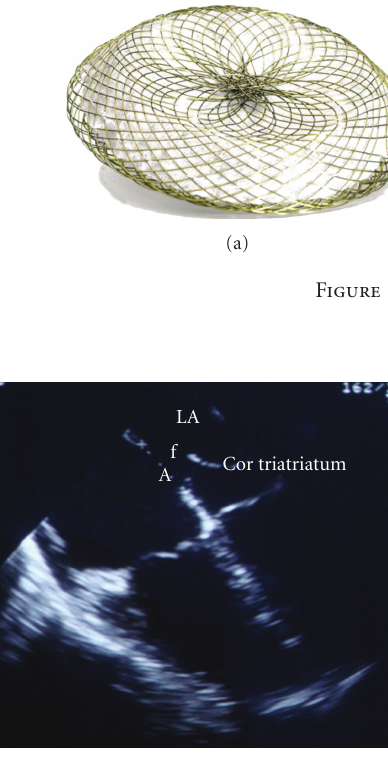
Figure 2: ASD secundum (A) and Cor triatriatum sinister with fen- estration (f).